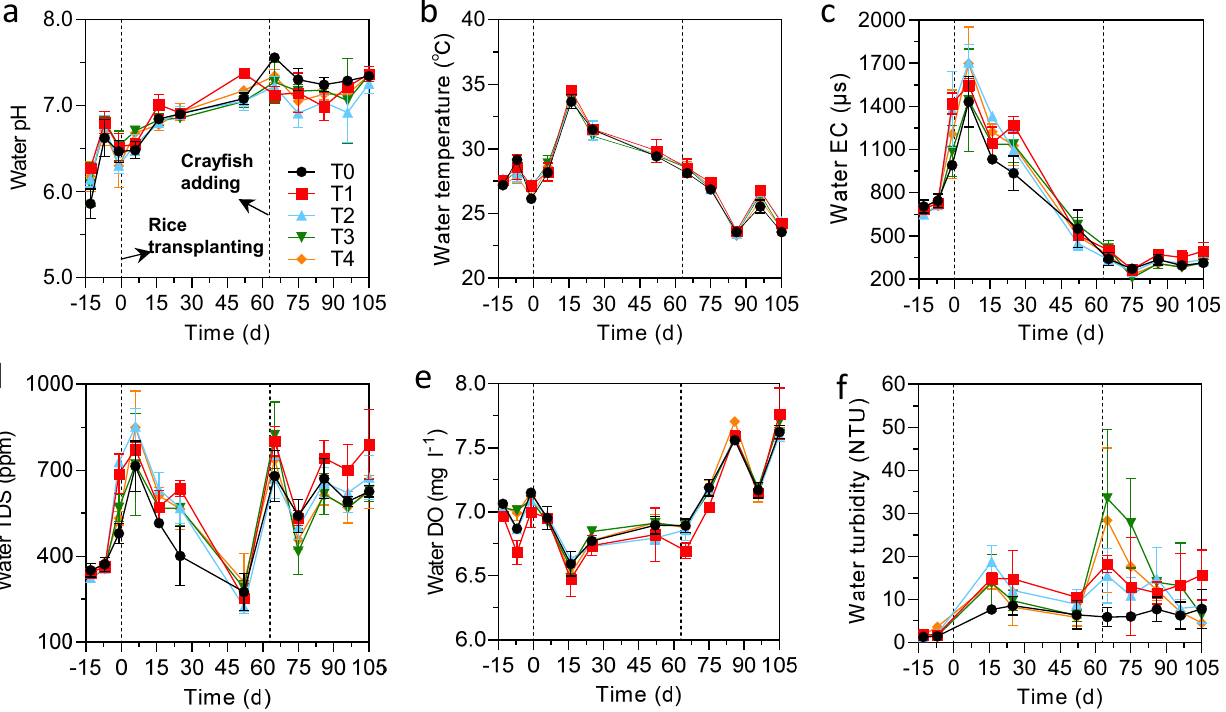
Figure 1. Dynamic changes of physicochemical indicators of water. ( a ) water pH; ( b ) water temperature; ( c ) water EC; ( d ) water TDS; ( e ) water DO; ( f ) water turbidity. The X-axis represents the experimental schedule.